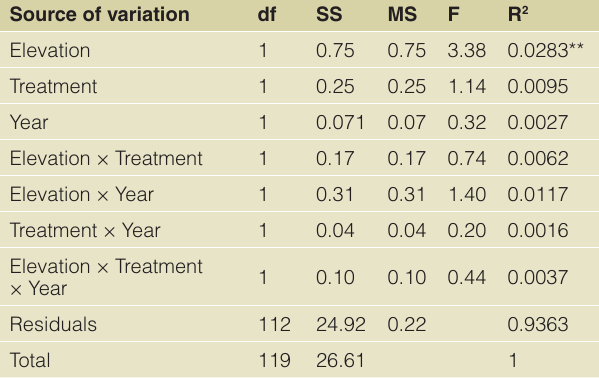
Table 7. ANOVA table from permutational multivariate Analysis of Variance to test differences in composition between mats at different elevations across years and treatments.